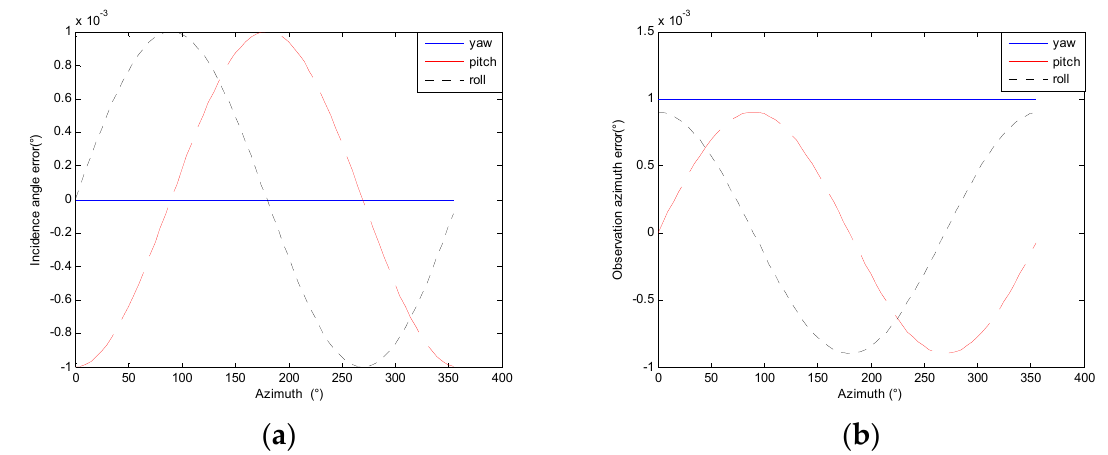
Figure 22. Incidence angle and observation azimuth measurement errors caused by satellite attitude determinations: ( a ) incidence angle error; ( b ) observation azimuth error.